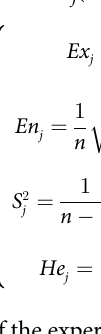
Table 2. Standard evaluation cloud parameters.